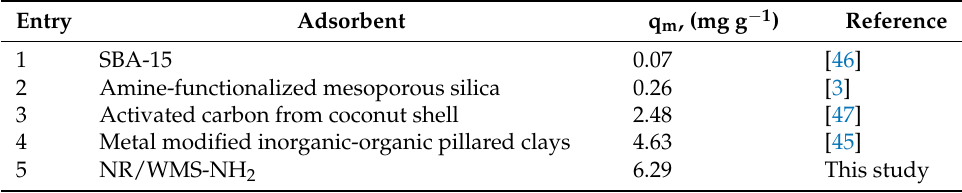
Table 6. Maximum capacities (q m ) of CFA adsorption onto different